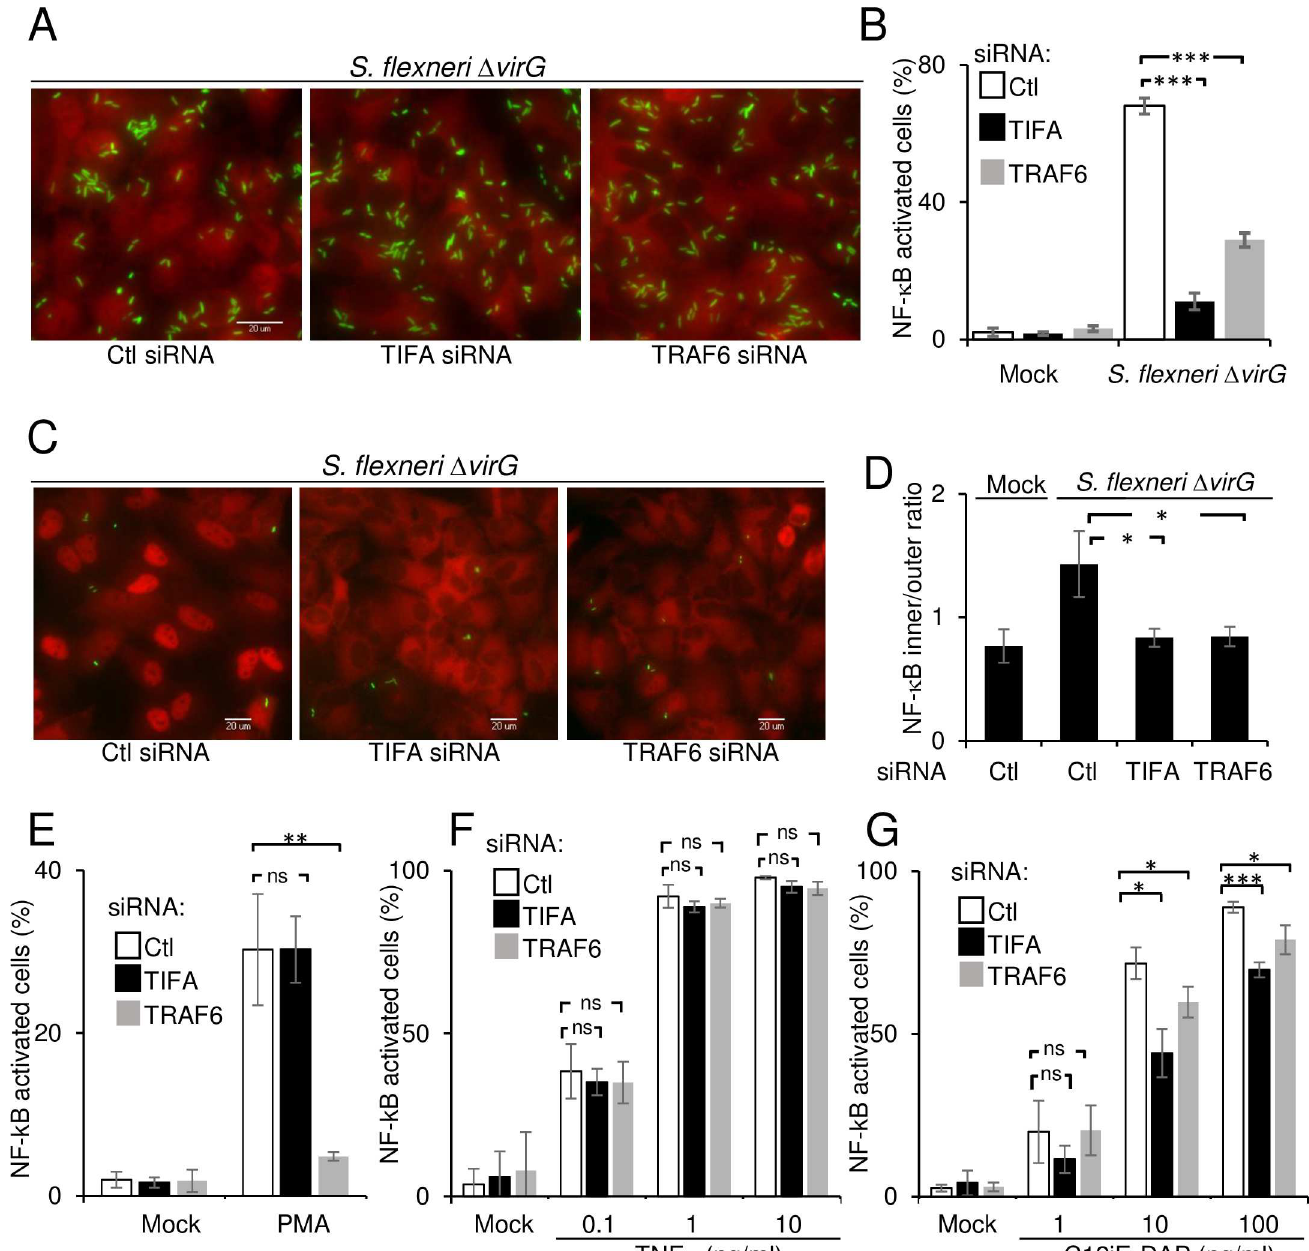
Fig 2. TIFA and TRAF6 control S . flexneri -induced NF- κ B activation. A) TIFA and TRAF6 control S . flexneri -inducedNF- κ B activationin infected cells. HeLa cells were transfected with control, TIFA- or TRAF6-targeting siRNAs and infected with S . flexneri Δ virG (green) at MOI 20 for 60 minutes. After fixation, cells were stainedfor NF- κ B p65 (red). B ) Quantificationof NF- κ B translocation in infected cells after depletionof TIFA and TRAF6. NF- κ B translocation was quantifiedby measuring the intensity ratio betweenthe nucleusand the cytoplasm by automatedimage analysis, defininga threshold ratio and quantifying the fraction of NF- κ B positive cells. Data correspond to the mean +/- SD of triplicate wells from a representativeof 3 independent experiments, p *** < 0.0005. C ) TIFA and TRAF6 control NF- κ B activationboth in infected and bystandercells. HeLa cells were treated as in A and infected at a MOI 0.5 (bacteria in green) for 60 minutes. After fixation, cells were stained for NF- κ B p65 (red). D ) Quantification of NF- κ B translocation in bystandercells. The fluorescence intensity ratio betweenthe cytoplasm and the nucleuswas measuredin bystandercells. Data correspond to the mean +/- SD of 3 independent experiments, p * < 0.05. E ) Impact of TIFA and TRAF6 depletionon PMA-induced NF- κ B activation. After siRNA transfection, HeLa cells were stimulatedwith PMA (100 ng/ml) for 60 minutes. Data correspond to the mean +/- SD of 3 independentexperiments, p ** <